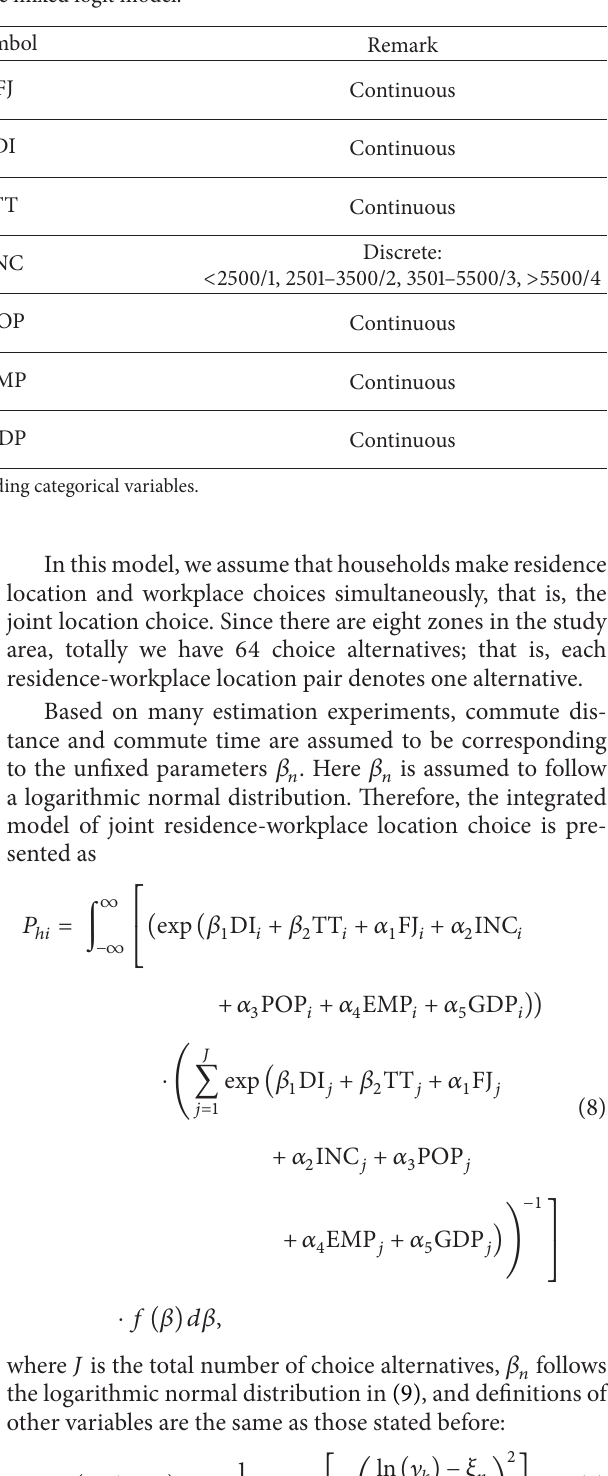
Table 2: Variables in the mixed logit